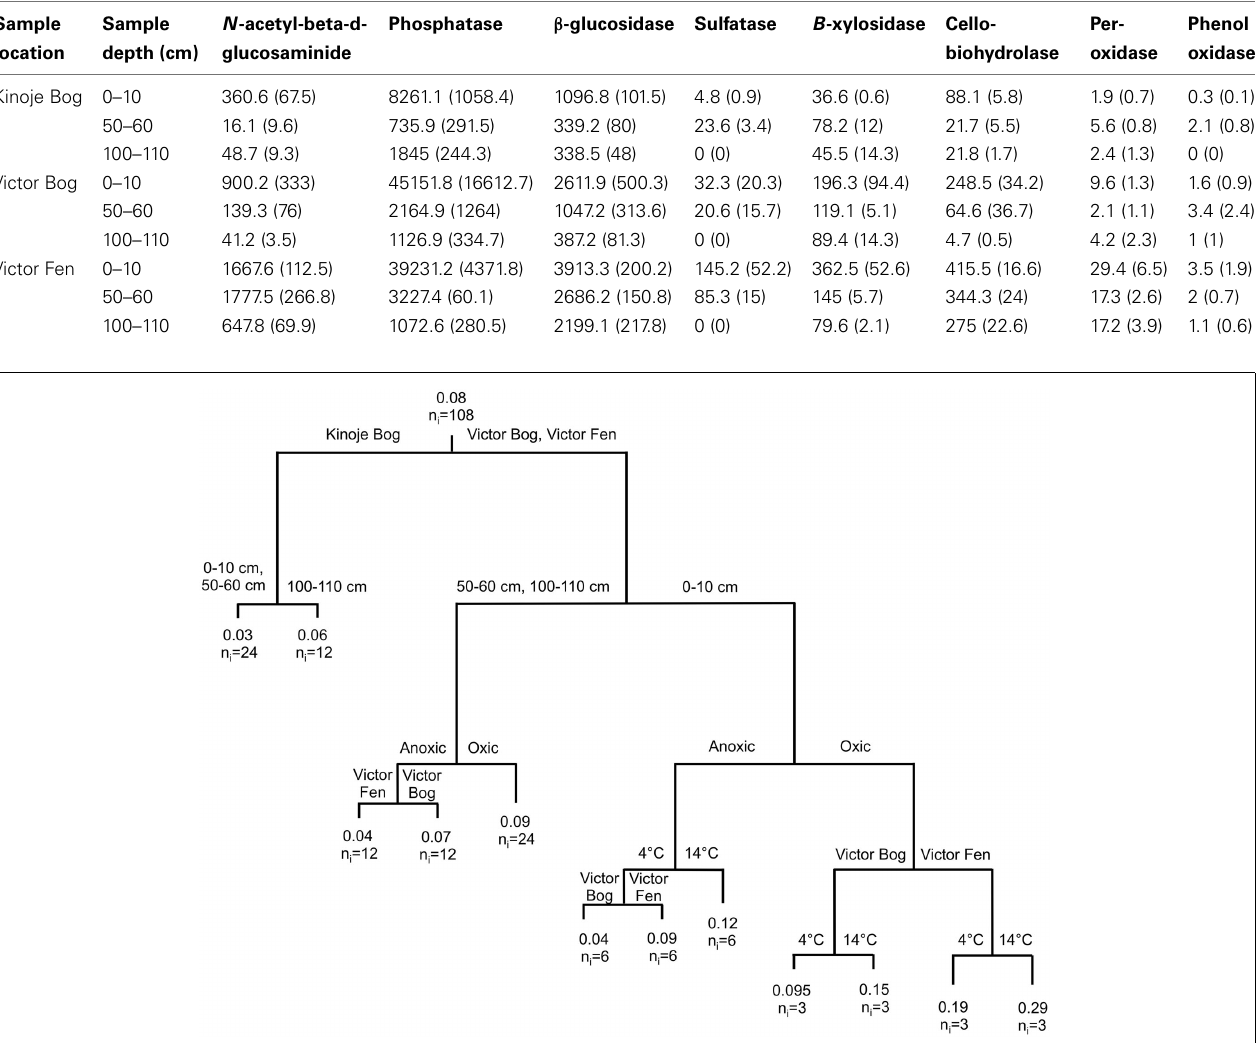
James Bay Lowlands, Canada. At each split the following information is given: the variable that splits the observation into “daughter” nodes, the classification criterion (e.g., peatland, depth, aeration, or temperature), the average potential CO 2 production rate and the number of observations in each group ( n i